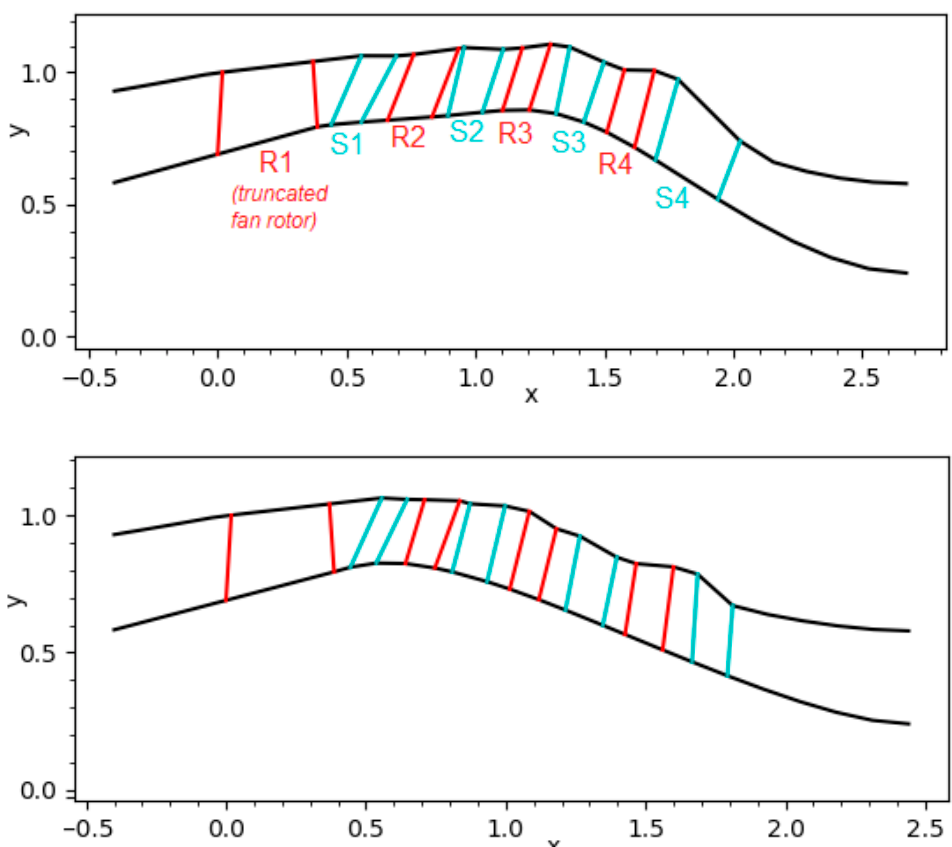
Figure 11. Two optimums showing flowpath for E 3 LPC with fixed truncated fan rotor from T-Axi.